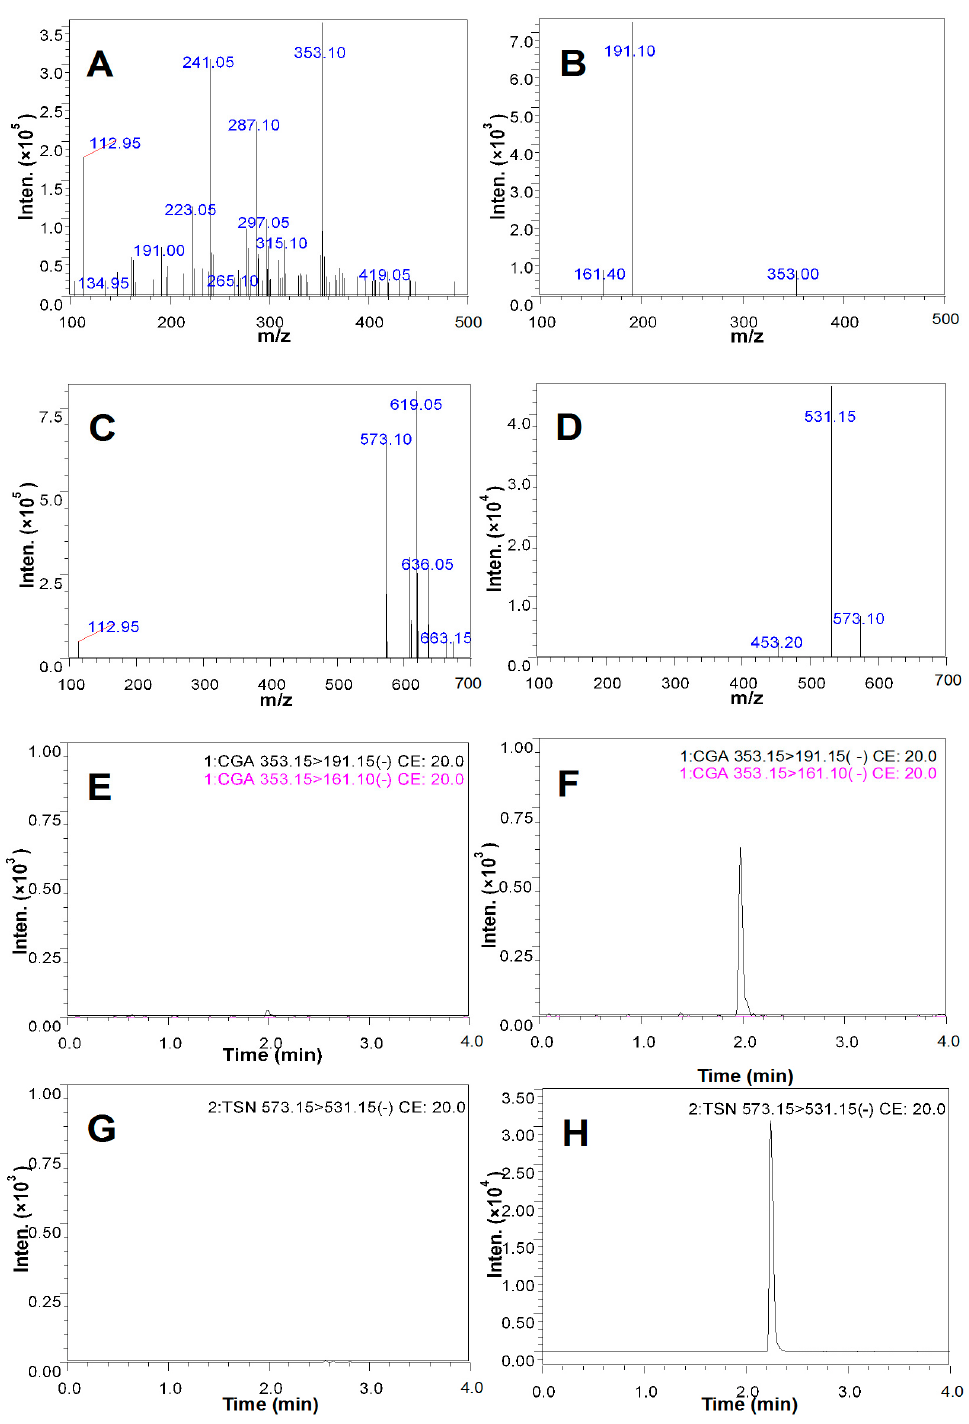
Figure 8. UHPLC-ESI-MS/MS chromatogram of CGA and toosendanin (TSN). ( A ) Negative Scan m / z 100–500 of CGA; ( B ) MS/MS spectrum of m / z 353.10 in the negative ion mode; ( C ) Negative Scan m / z 100–700 of TSN; ( D ) MS/MS spectrum of m / z 573.10 in the negative ion mode; ( E ) MRM of channels ESI − 353.10/191.15 and 353.10/161.10 for blank CSF sample; ( F ) MRM of channels ESI − 353.10/191.15 and 353.10/161.10 for CSF spiked with CGA; ( G ) MRM of channels ESI − 573.15/531.15 for blank CSF sample; ( H ) MRM of channels ESI − 573.15/531.15 for CSF spiked with TSN. Notes: Chromatographic conditions are provided in the Experimental Section.